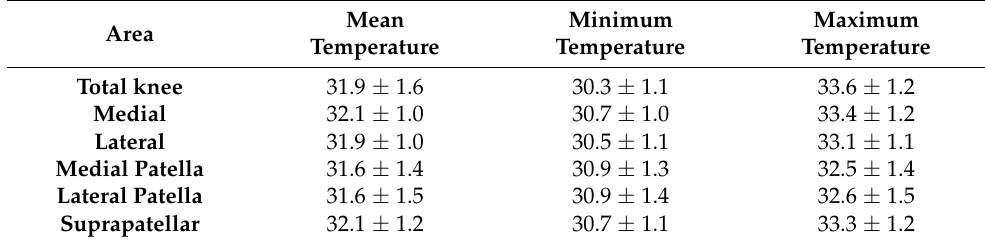
Table 2. Temperatures of the evaluated knee areas.